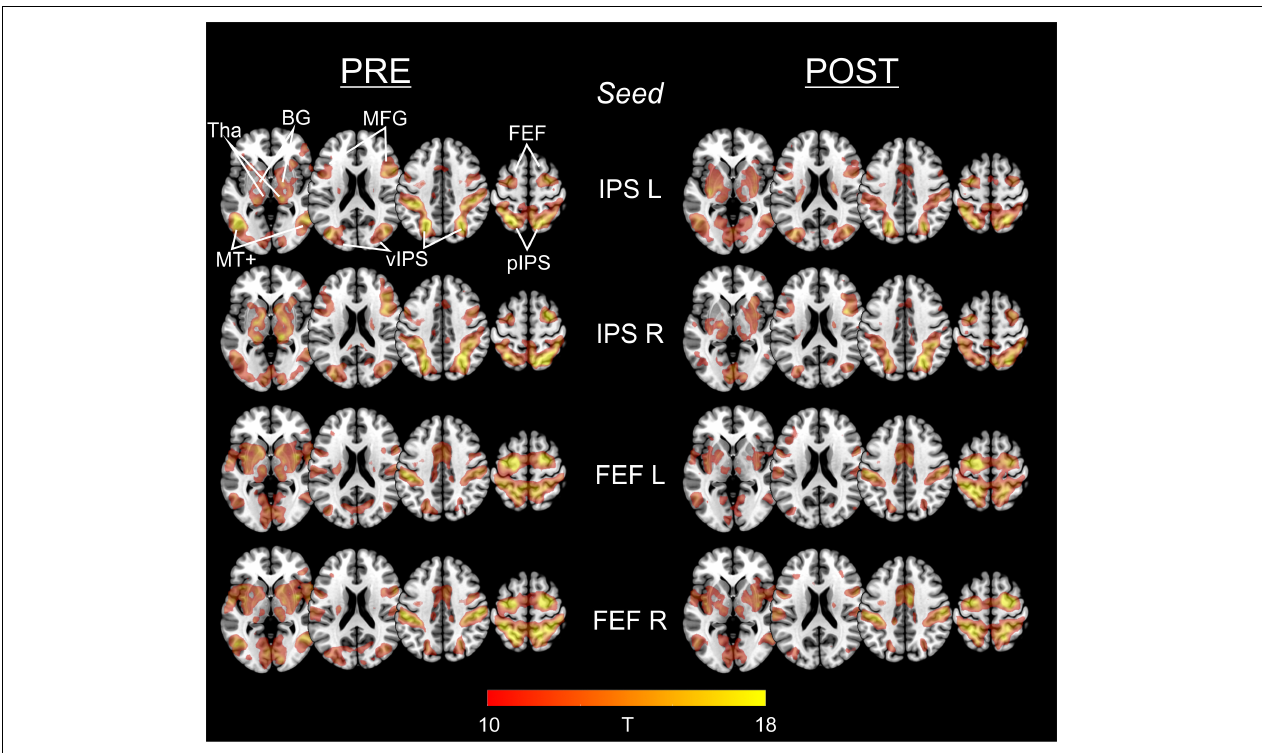
FIGURE 2 | Functional connectivity of IPS and FEF seed regions in PRE and POST run. For each of the predefined DAN-ROIs (bilateral IPS and FEF) and separately for the rs-fMRI run before (PRE) and after (POST) task performance, group statistical FC maps were obtained using one-sample t -tests on the individual Fisher’s z-transformed correlation maps, corrected for multiple comparisons applying a false family-wise error (FWE) at p < 0.05. Results are presented at a threshold of T > 9.86 (equals FWE-corrected p < 0.00001), depicted on axial slices ( z : 0, 30, and 60) of a MNI brain template. The predefined seed-ROIs almost uniformly show functional connections to other DAN regions including ventral/posterior IPS and FEF, middle frontal gyrus (MFG), middle temporal complex (MT+) as well as to the basal ganglia (BG) and thalamus (Tha).